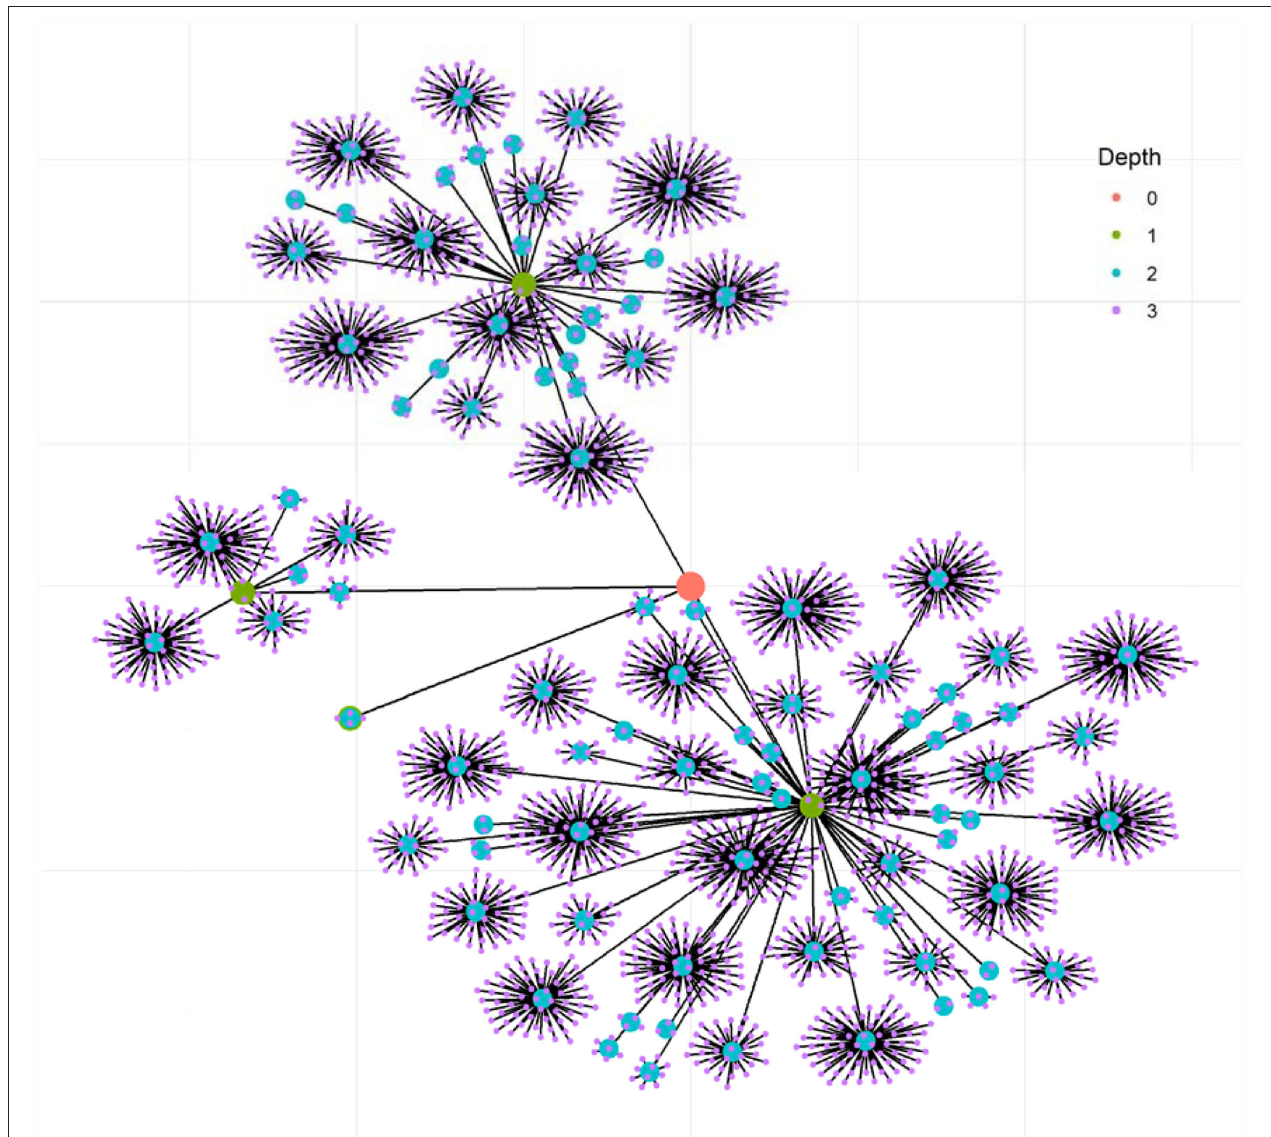
FIGURE 3 | Illustration of the reposting of Diliraba’s “#national mask campaign#” on Sina Weibo. This plot illustrates how Diliraba’s “#national mask campaign#” is being spread through levels of reposts on Sina Weibo. The network was simulated based on 1:10,000 statistics of the real data.